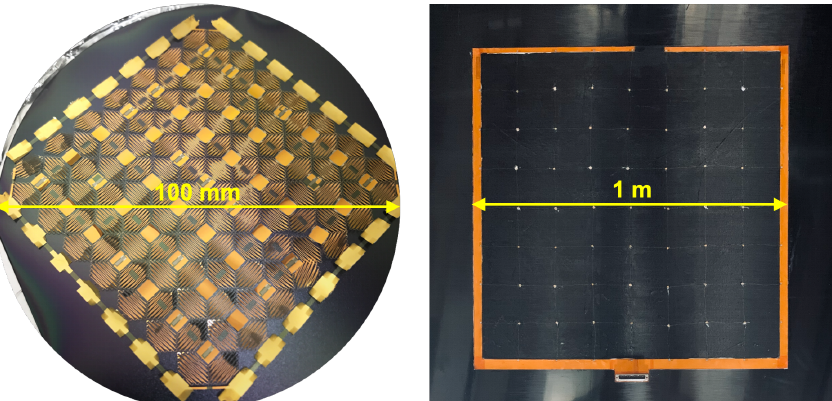
Figure 1. ( Left ) An SSN in its unstretched state. ( Right ) A stretched and deployed SSN on a composite